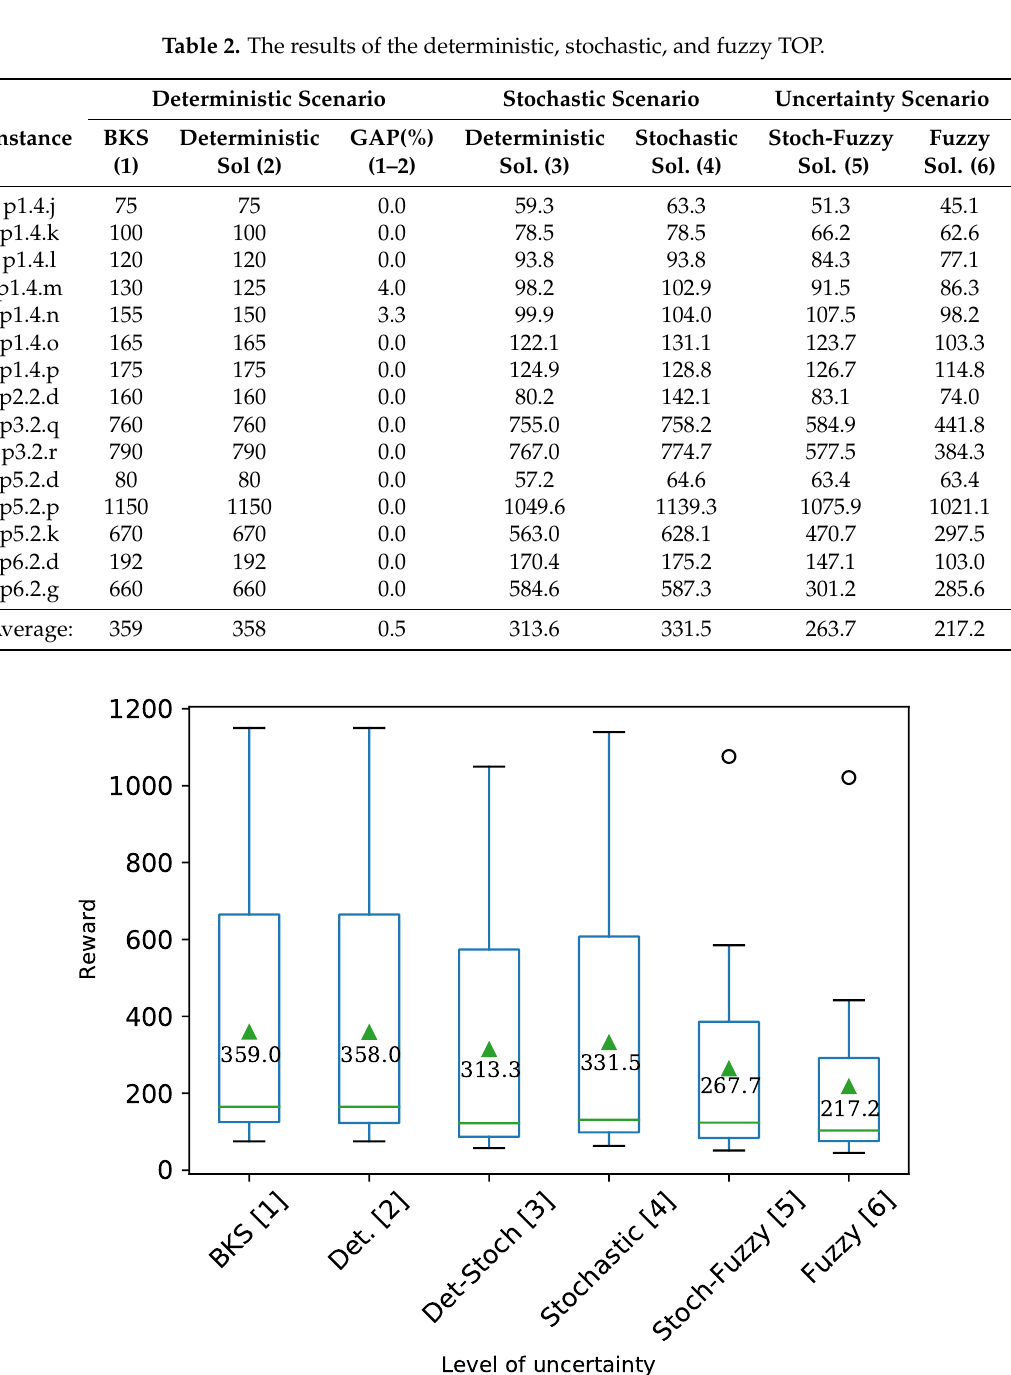
Figure 7. Boxplots showing the rewards for each TOP variant (with increasing uncertainty